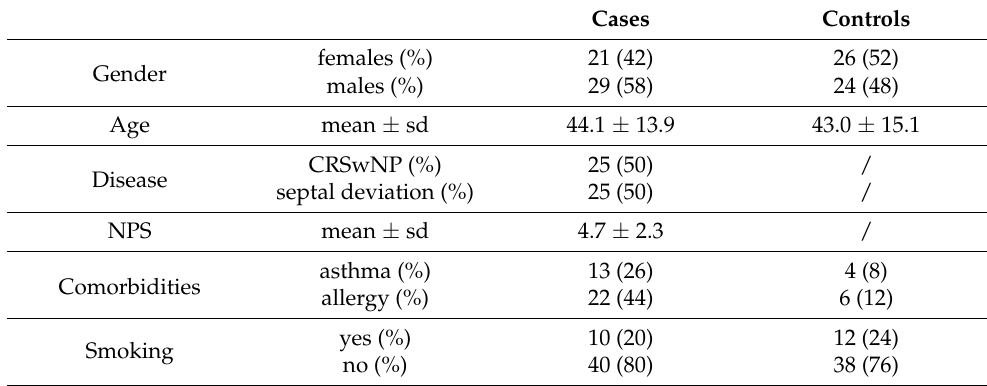
Table 1. Characteristics of the population. sd = standard deviation; NPS = Nasal Polyps Score.